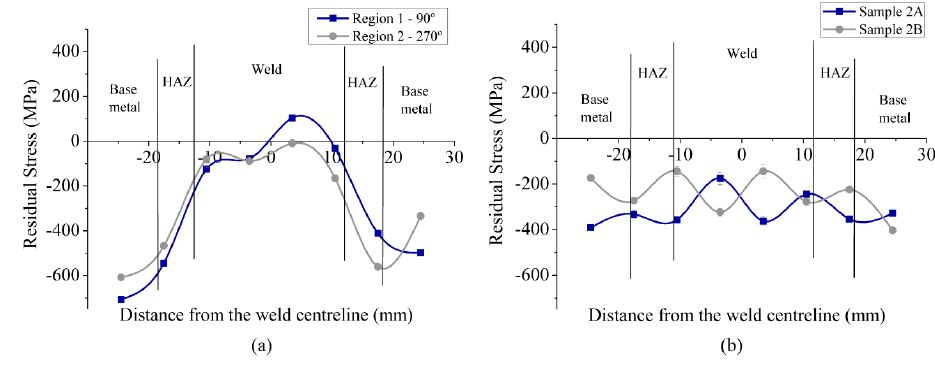
Figure 3. Residual stress on the cap region (a) sample 1; (b) sample